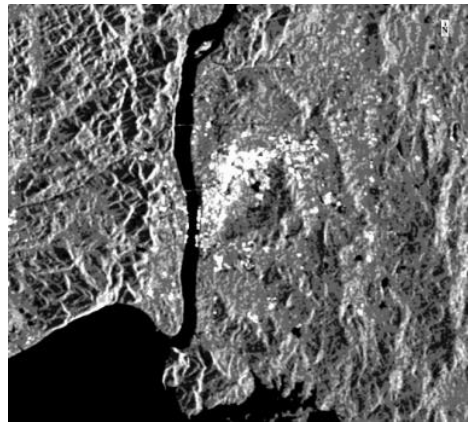
Figure 4. Enlarged view of the homogeneity